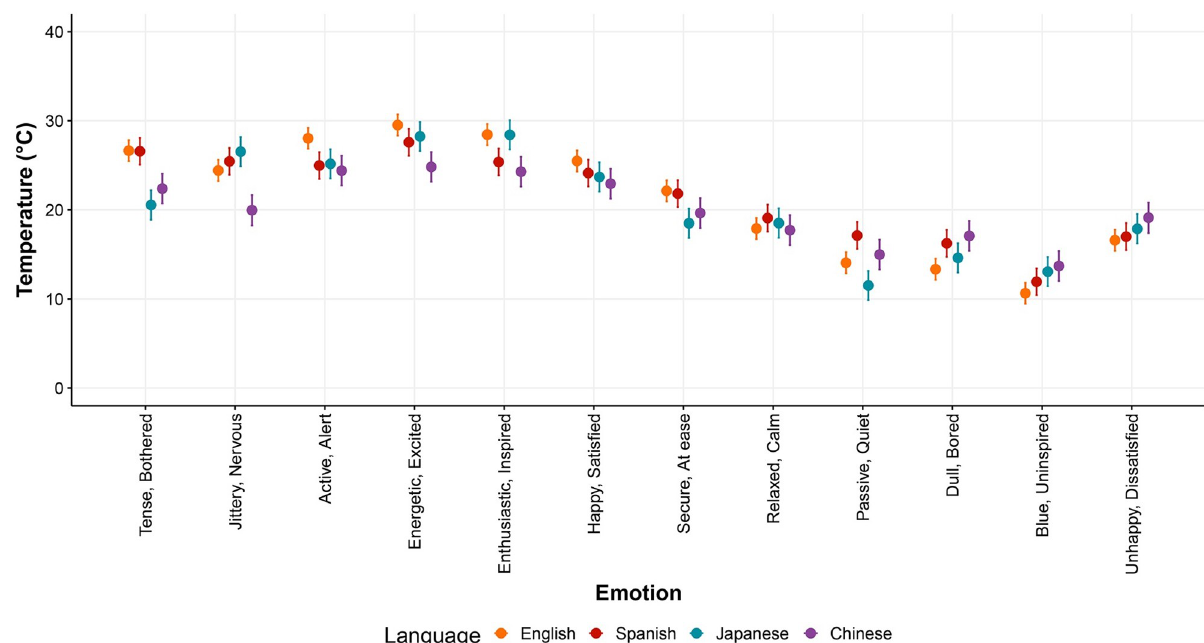
Fig 5. Mean temperature association ratings following Model 1 of the linear mixed model (LMM) analysis using temperature as a continuous variable. The emotion adjectives appear in the x-axis, and the languages are color-coded. The error bars represent the confidence intervals.